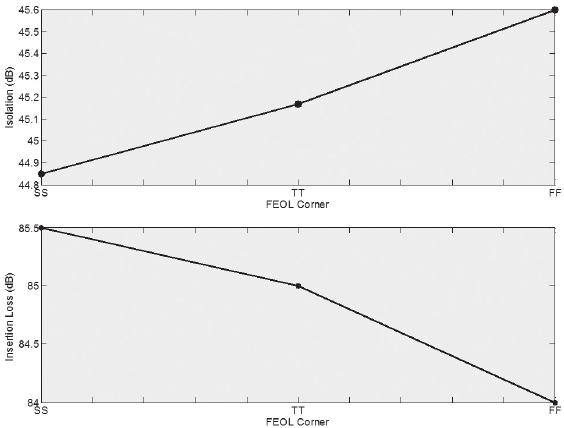
Figure 8 - FEOL Corner